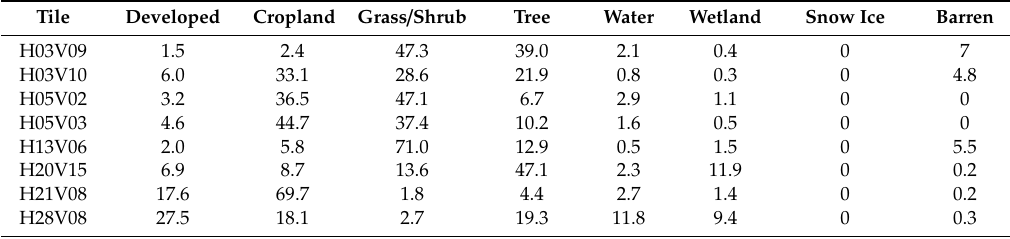
Figure 1. Landsat Landsat Analysis Ready Data (ARD) tiling scheme for the conterminous United States. The orange tiles show the locations of evaluation sites used in the preliminary Land Change Monitoring, Assessment, and Projection (LCMAP) evaluation. These tiles were selected to represent different land cover types and ecosystems across the conterminous Unites States (CONUS). Table 2. Land cover percentage (%) in the eight Landsat Analysis Ready Data (ARD) tiles derived from the cross-walked National Land Cover Database (NLCD) 2011.